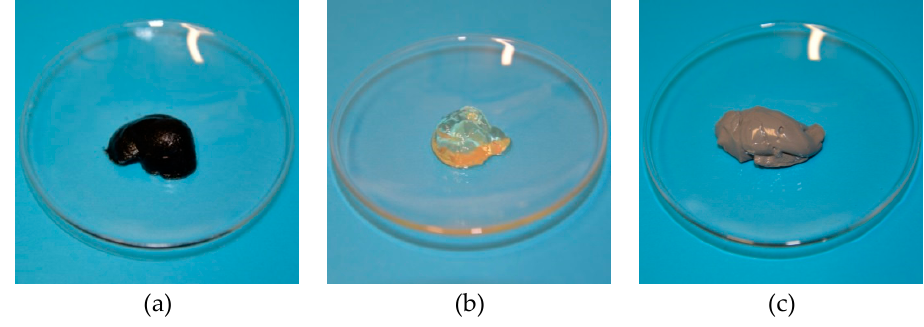
Figure 21. Different gel samples. ( a ): versatile monopropellant with carbon-/urea-based gellant; ( b ): water-based propellant substitute; ( c ): metallized high performance monopropellant gel.